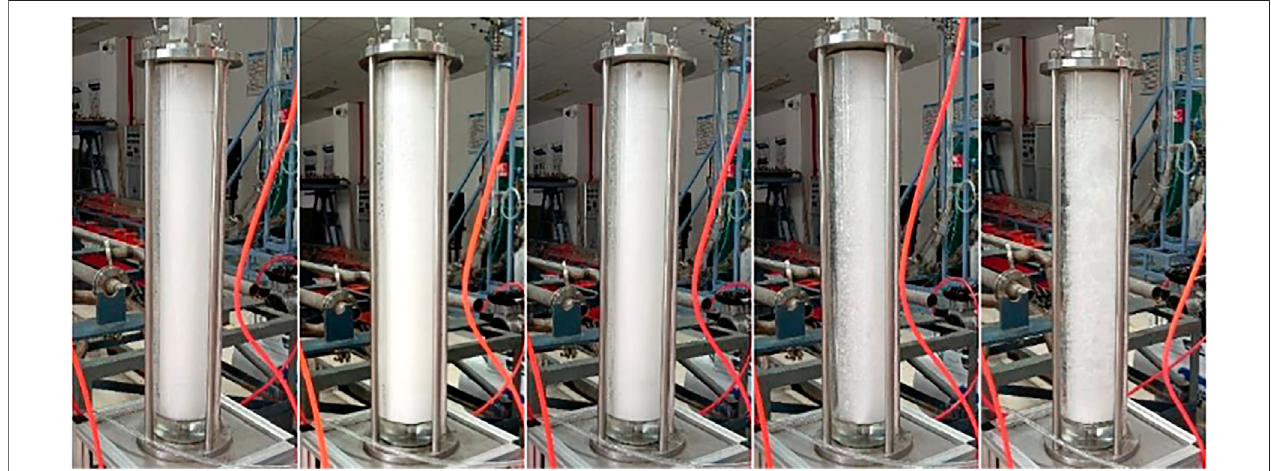
FIGURE 6 | Dynamic bubble drainage and liquid-carrying process under the condensate content of 10%, 20%, 30%, 40%, and 50%.